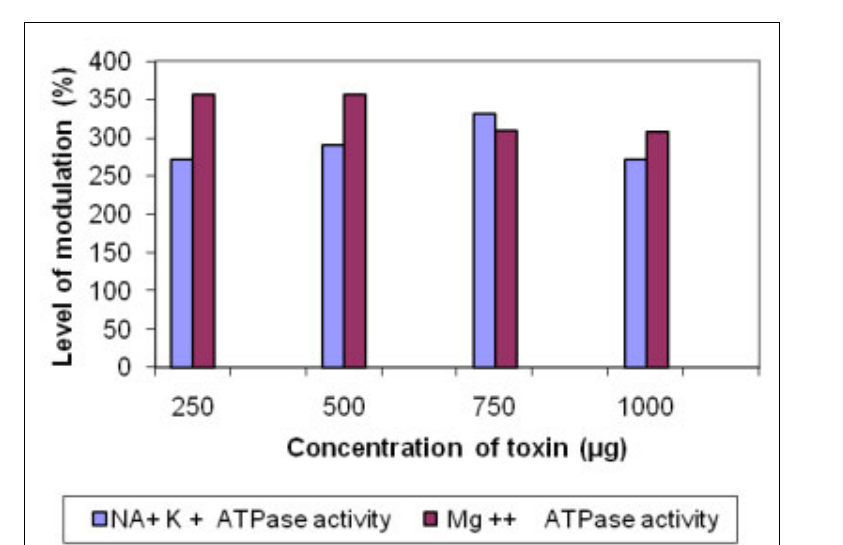
Figure 3. Modulation of Na + -K + ATP-ase and Mg ++ ATP-ase activity by the aqueous extract of Halichondria panicea .